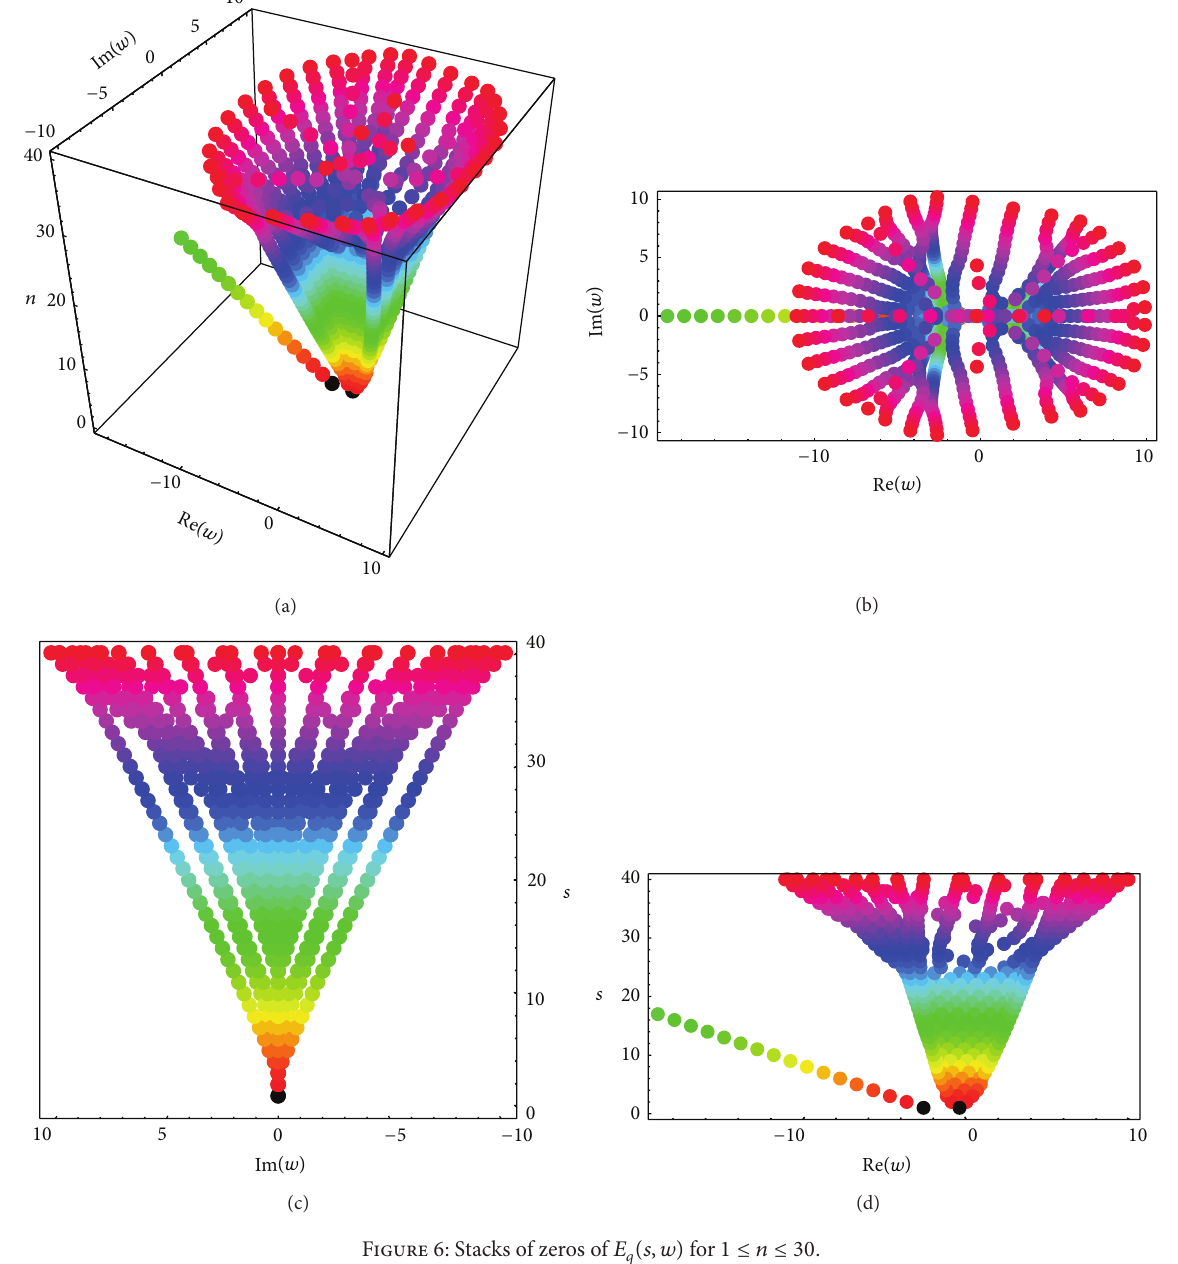
Figure 6: Stacks of zeros of 𝐸 𝑞 (𝑠,𝑤) for 1 ≤ 𝑛 ≤ 30